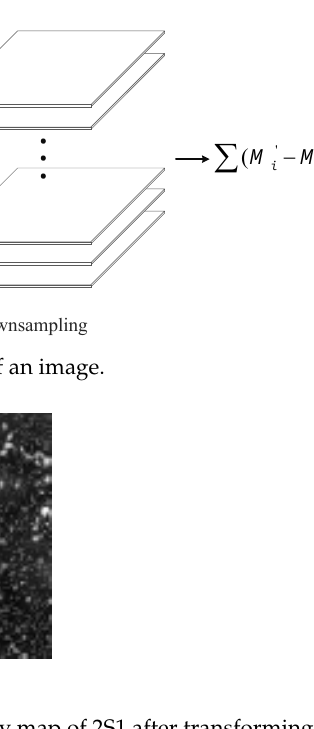
Figure 5. Saliency map result. ( a ) 2S1, ( b ) saliency map of 2S1 after